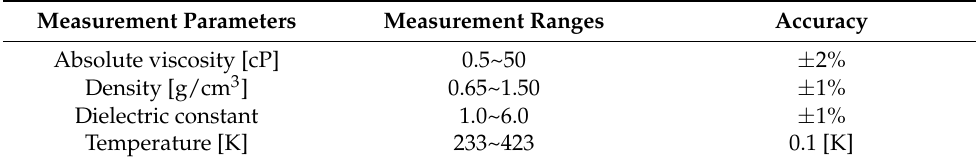
Figure 1. Overall view of tuning fork sensor for hydraulic oil. Table 2. Specification of tuning fork sensor (@Temperature = 373